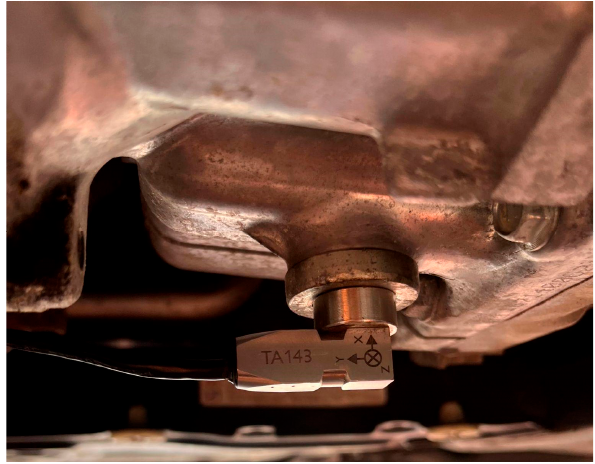
Figure 2. The location of the accelerometer on the transmission.